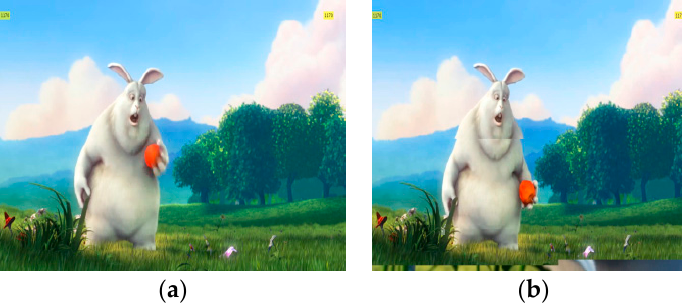
Figure 8. ( a ) Transmitted image and ( b ) received image (distorted), label = 1170 at time 65